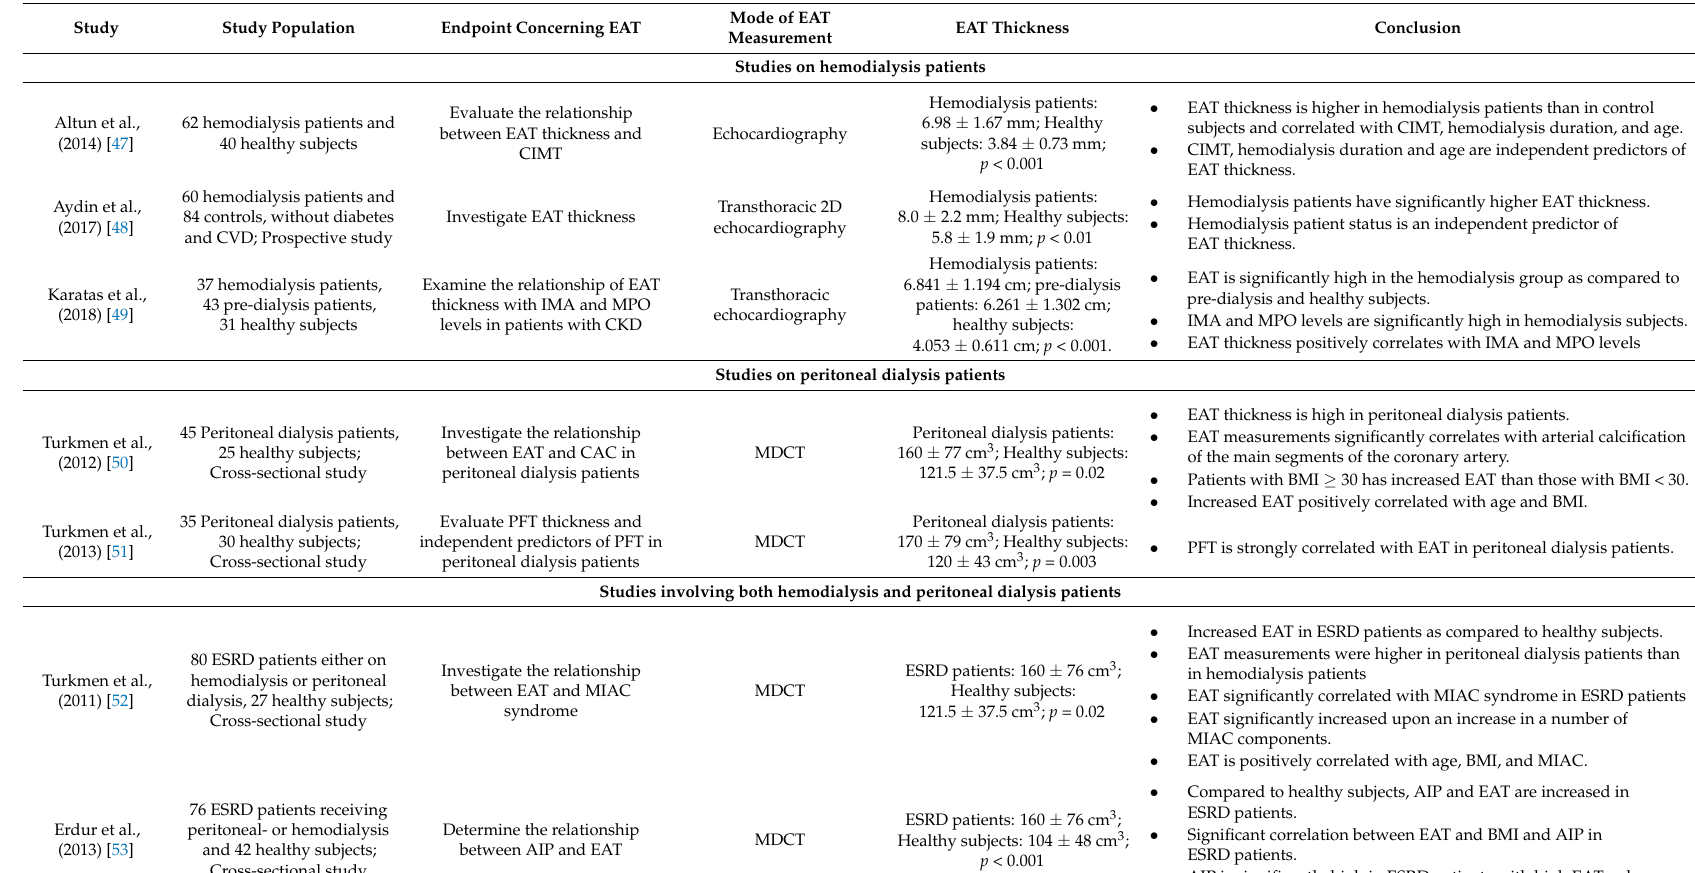
Table 2. Studies evaluating the EAT thickness in patients on